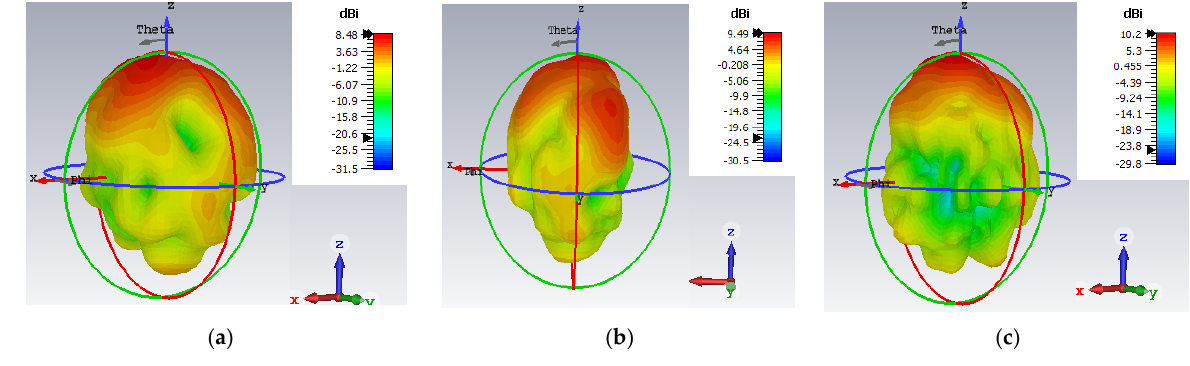
Figure 12. 3D radiation of element 1 at ( a ) 26 GHz, ( b ) 30 GHz, and ( c ) 35 GHz.